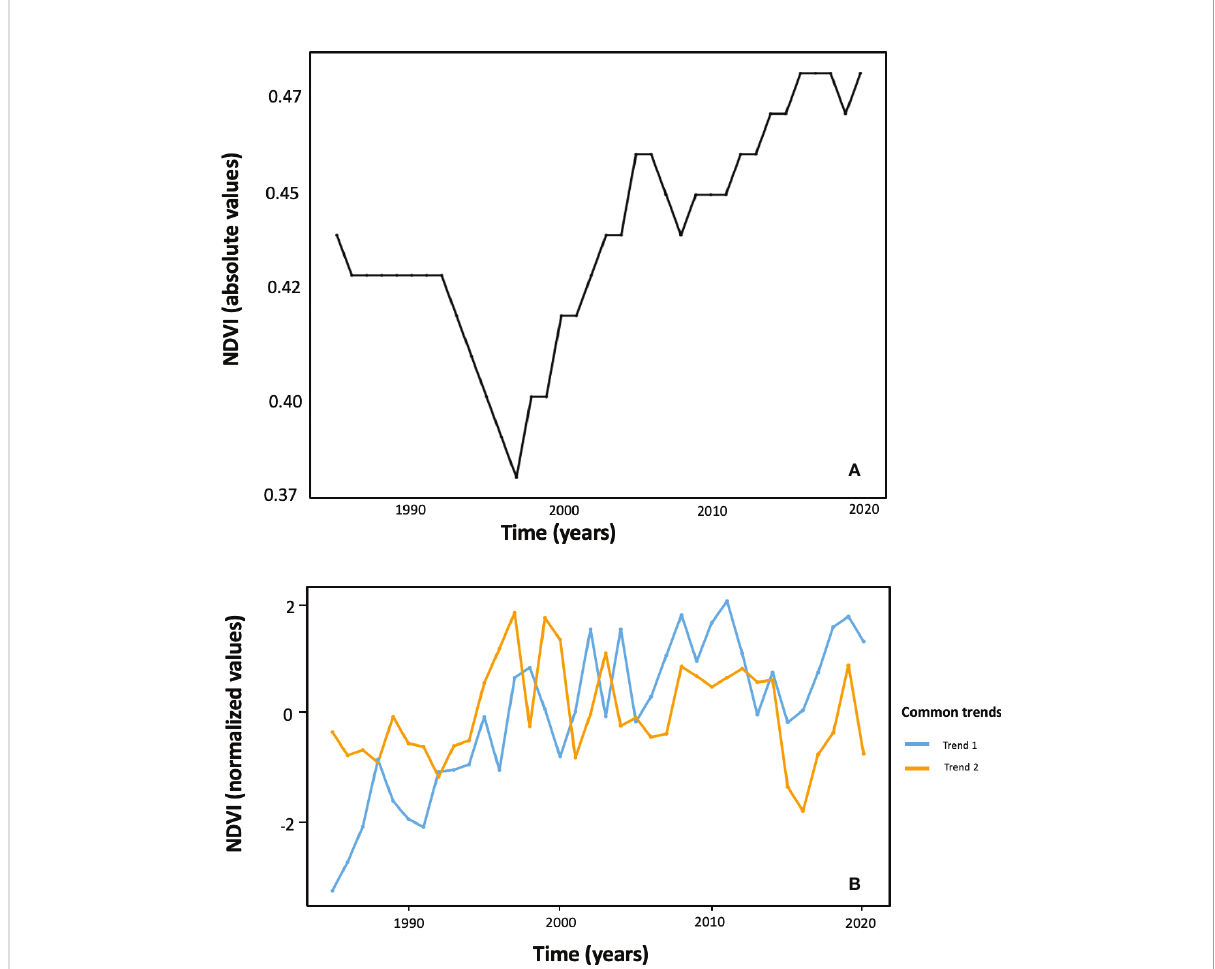
FIGURE 6 Common temporal trends among the nine NDVI time series corresponding to the different altitude by solar incidence combinations, as revealed by Dynamic Factor Analysis (DFA) performed both on absolute (graph A ) and on normalized (graph B )